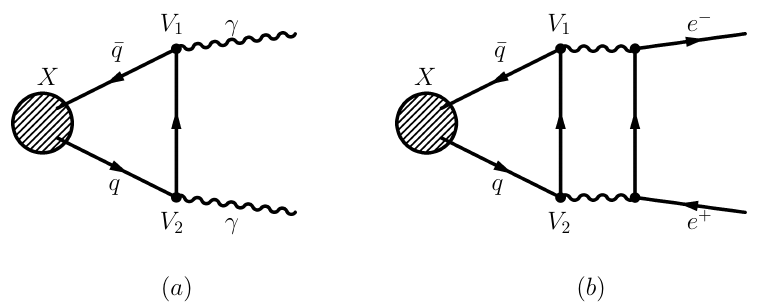
Figure 3 . Decay of the QED meson X into ( a ) a (cid:13)(cid:13) pair, and ( b ) an e + e (cid:0)